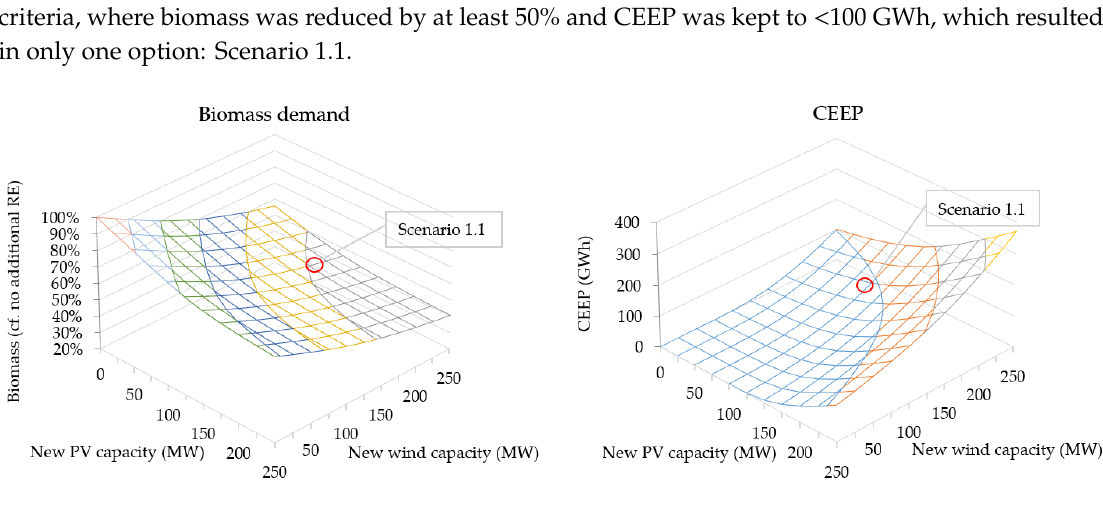
Figure 3. Sensitivity study for an electrified energy system, including optimal Scenario 1.1—resulting additional biomass demand and critical excess electricity production (CEEP).